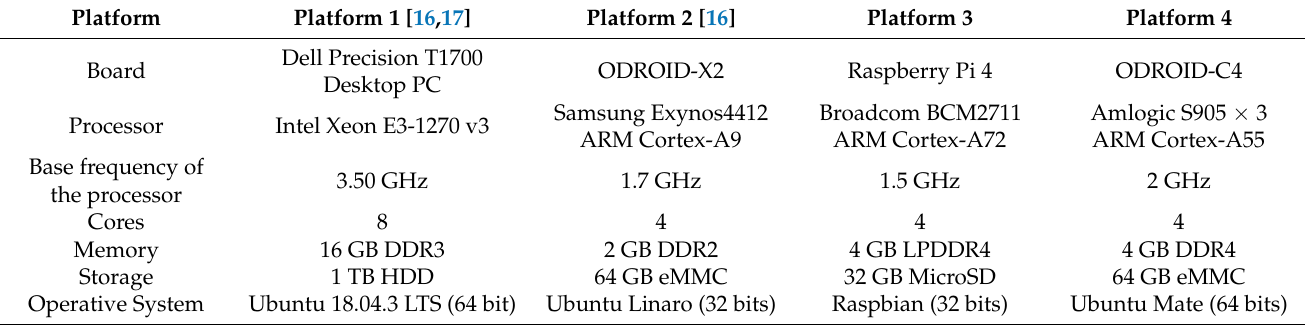
Table 2. Platforms used for the software profiling analysis. © [2020] IEEE. Extended, with permission, from